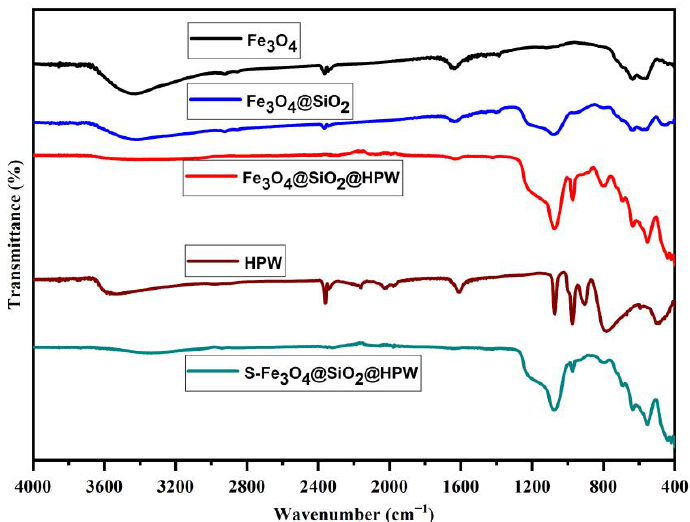
Figure 5. FTIR spectra of Fe 3 O 4 , Fe 3 O 4 @SiO 2 , Fe 3 O 4 @ SiO 2 @HPW, HPW, and spent catalyst (S- Fe 3 O 4 @ SiO 2 @HPW) .